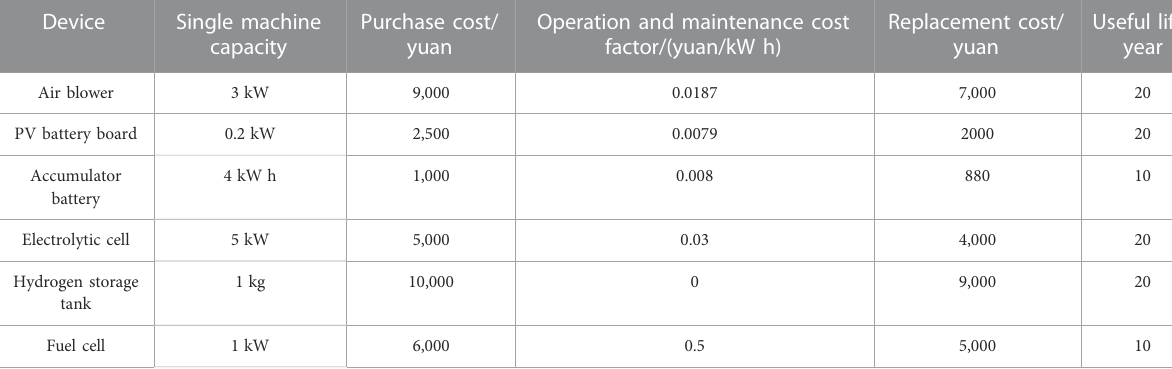
TABLE 2 Related technical parameters of each device in the system.